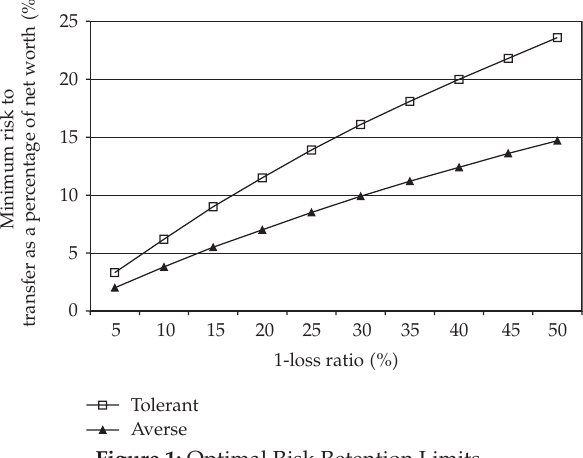
Figure 1: Optimal Risk Retention